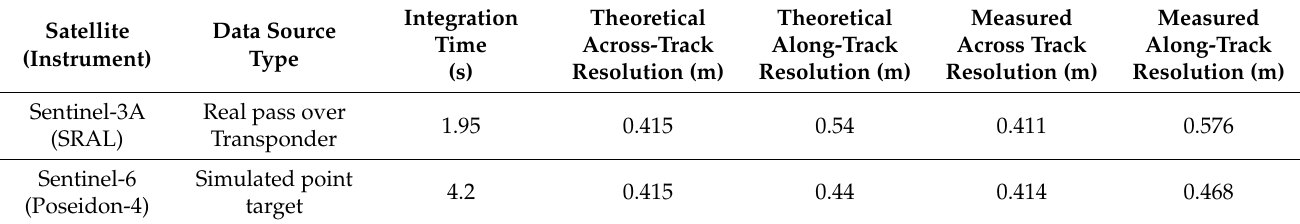
Figure 3. ( a ) The 2D-focussed Impulse Response Function (IRF) of a Fully-Focussed SAR (FF-SAR) processed Sentinel-3A real pass over Crete transponder on 14 June 2019. ( b ) A 2D-focussed IRF of an FF-SAR processed Sentinel-6 simulated pass-over transponder. The width of the main lobe on the across-track and along-track directions provides the estimates of the across-track and along-track resolutions, respectively. Table 4. FF-SAR processor results over point targets.